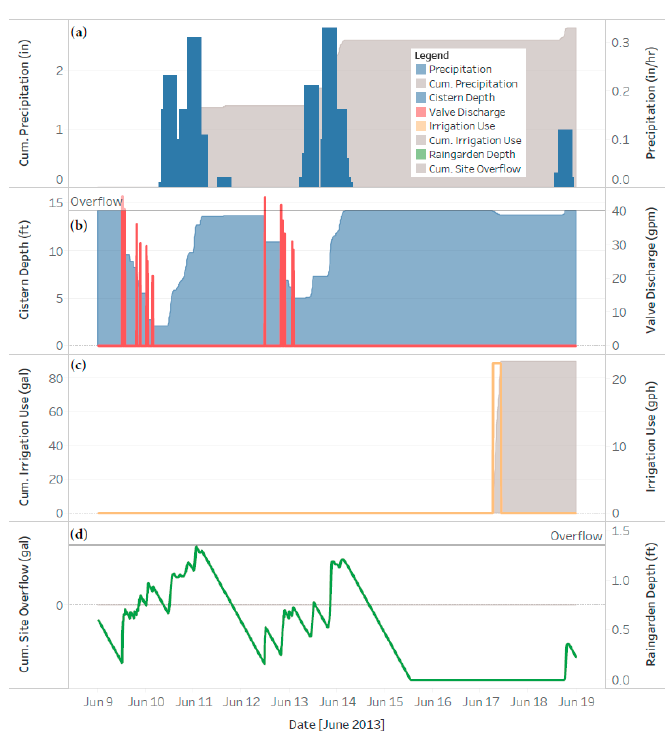
Figure 5. Active Scenario Performance (9 June 2013–19 June 2013): ( a ) Rainfall occurred on 10 June